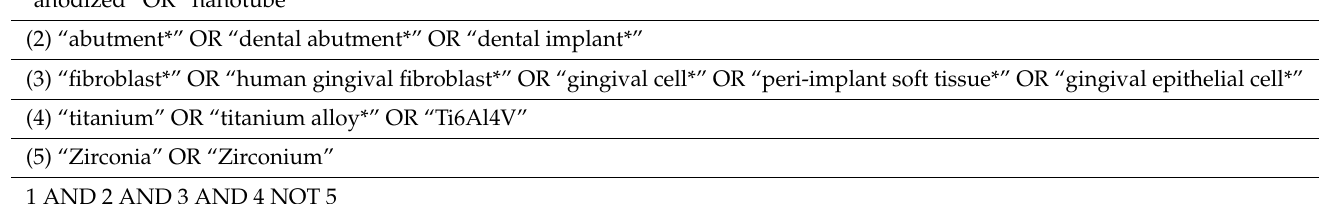
Table 1. Search strategy and